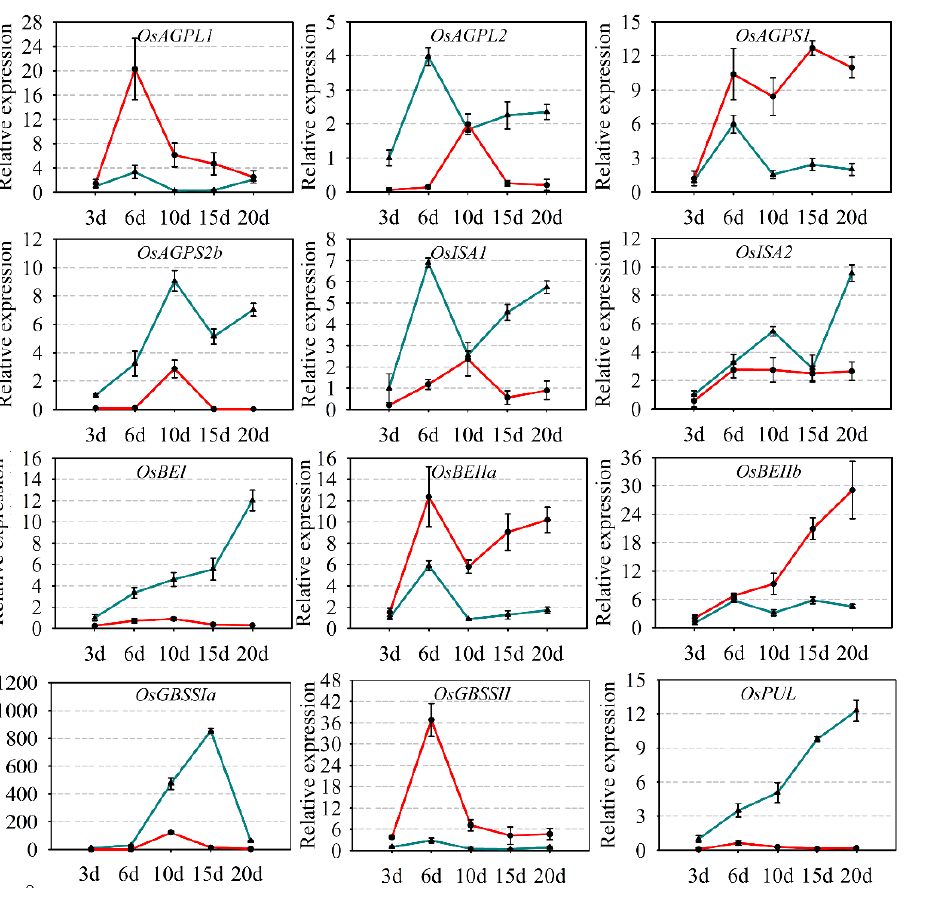
Figure 7. Expression profiles of 18 rice starch synthesis genes during development of Zhonghua 11 (wild-type) and the m-1a strain. The gene expression in the 3-d endosperm of wild-type rice was